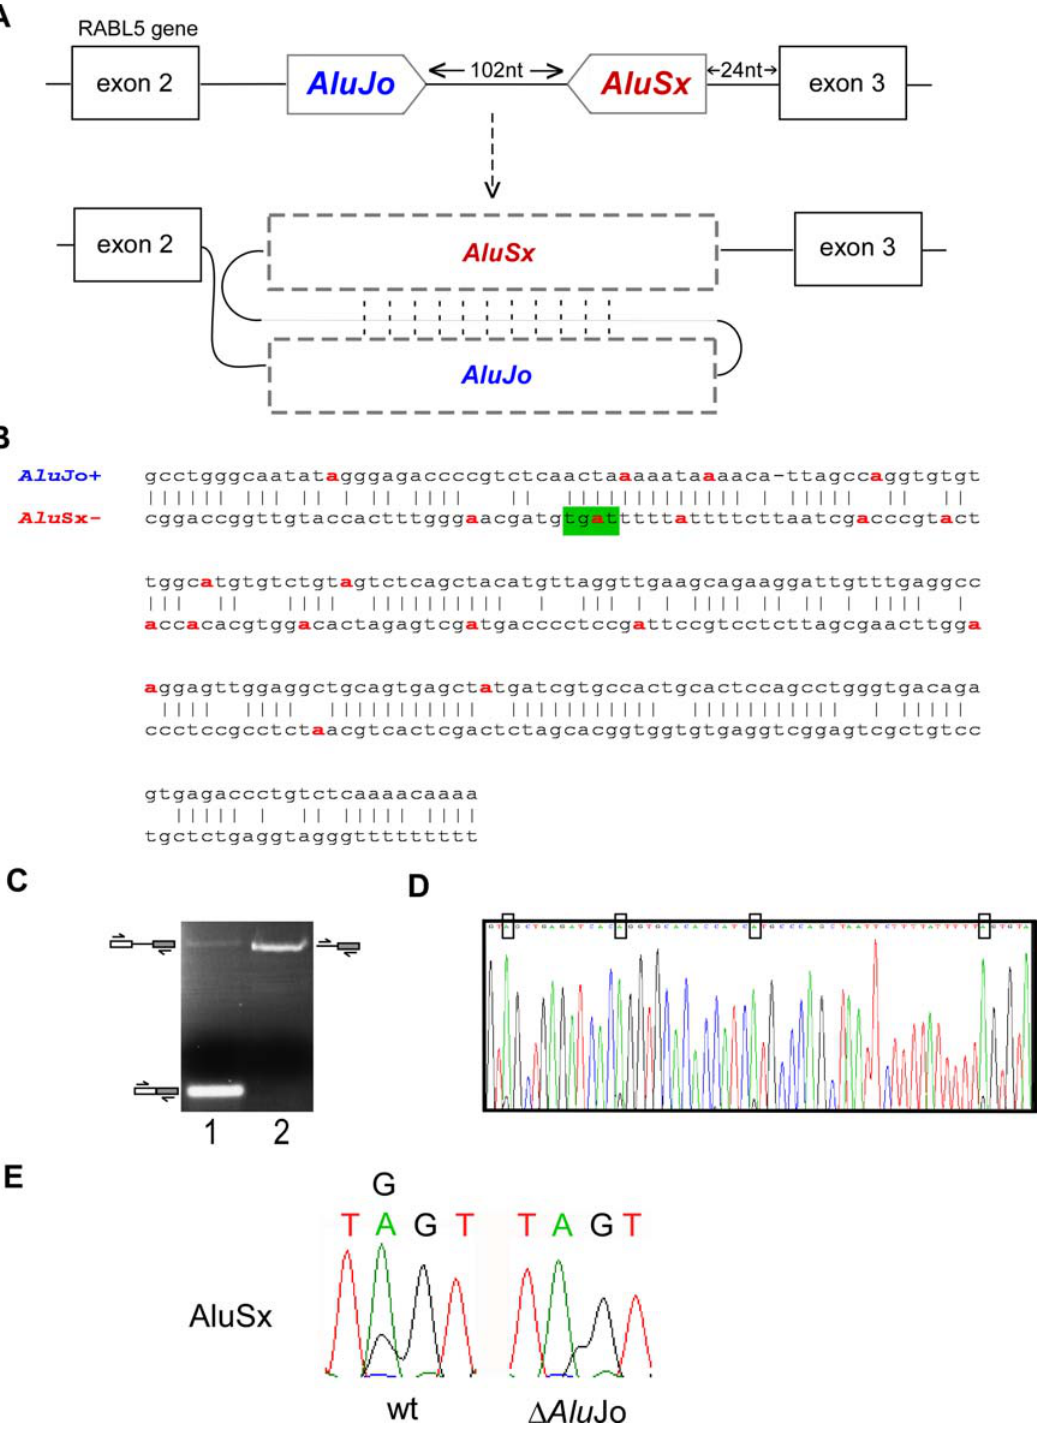
Figure 3. Editing sites within the intronic Alu s. (A) Schematic illustration of exons 2 to 3 of the RABL5 gene. Exons are depicted as black boxes; the intronic Alus , derived from Alu Jo and Alu Sx, in sense and antisense orientations, respectively, are shown in the middle gray-shaped boxes. The intronic, antisense Alu sequence ( Alu Sx) is 102 nucleotides downstream of the sense Alu Jo and Alu Sx is 24 nucleotides upstream of the junction of exon 3. Sense and antisense Alu s are expected to form a double-stranded secondary structure, thus allowing RNA editing. (B) Editing sites were inferred from alignment of five cDNAs (accession numbers BC050531, BC038668, BI547904, BI548328, and DB495755) to the human genomic DNA. RNA editing occurs at eight positions within the antisense Alu Sx and at eleven positions within the sense Alu Jo. Based on these editing sites, the pairing between the sense and antisense Alu sequences was inferred (upper and lower lines, respectively). The region in which editing occurs starts at the middle of the right arm (position 232 in the AluSx consensus) and ends at the beginning of the left arm of Alu 2 (position 101 in the AluSx consensus). Panel B shows only this corresponding region, while the entire Alu - Alu potential dsRNA is shown in Figure S3. (C) To further confirm the editing activity, total RNA was extracted from a neuroblastoma (SH-SY5Y) cell-line and treated with DNaseI, followed by RT-PCR analysis using primers